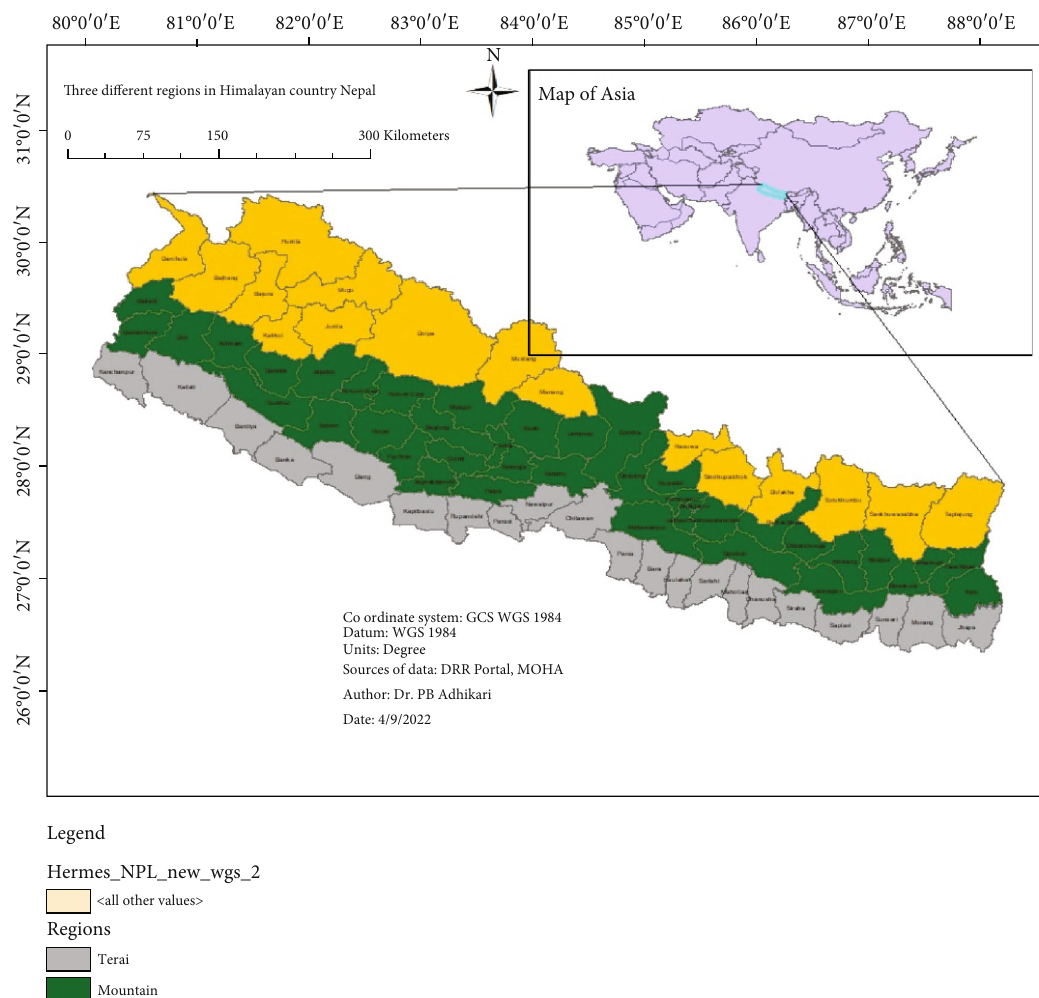
Figure 5: The three di ff erent regions — Terai, Mountain, and Himalayan in Nepal as shown by a di ff erent color of very small breadth and elongated from east to west. Using the software of ARCGIS mapping Nepal is also shown in the inset of the map of Asia with latitude and